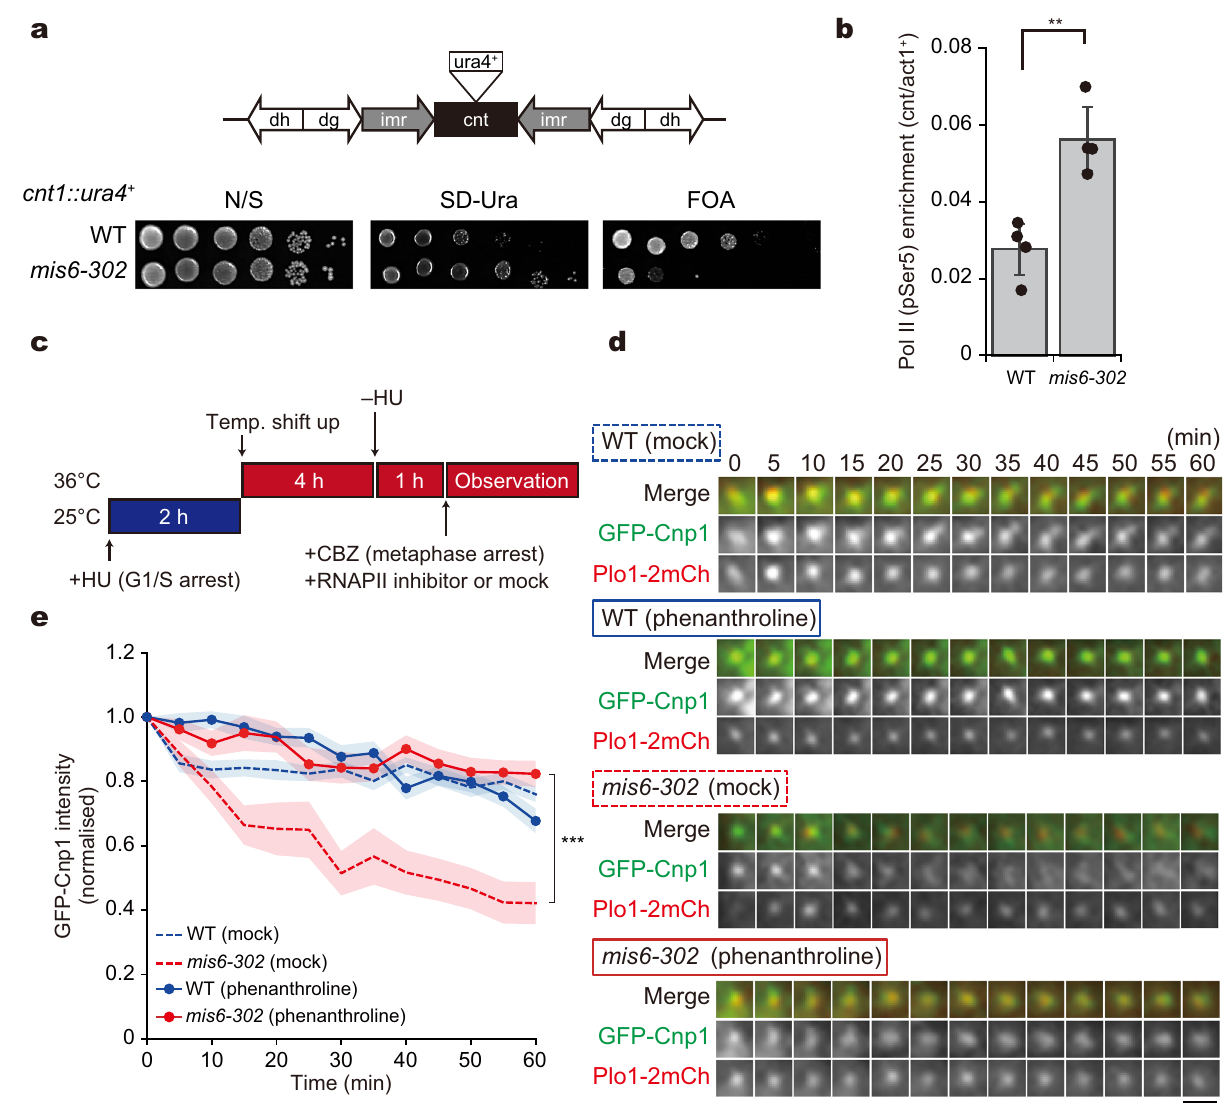
Fig. 4 Loss of Cnp1 in mis6-302 cells is coupled with centromeric transcription by RNA polymerase II. a A schematic illustrating the centromeric DNA structure and ten-fold serial dilution assay. For silencing assays, the ura4 + gene is inserted in the central core ( cnt ) region ( cnt::ura4 + ) in chromosome I. imr , the innermost repeats; dg and dh , the outer repeats. Ten-fold serial dilution of WT and mis6-302 cells with cnt::ura4 + , grown on nonselective (N/S), uracil-de fi cient (SD – Ura) and counter-selective (5- fl uoroorotic acid, FOA) media at 25 °C. b Chromatin IP (ChIP) for phosphorylated RNA polymerase II (RNAPII pSer5) at cnt region (the central core region) in WT and mis6-302 cells at 36 °C (4 h). The % input of the cnt region was normalised to that of the act1 + region. Error bars = ±s. d. ( N = 4 experiments). ** p < 0.01 (Welch ’ s t -test). c – e RNAPII was inhibited in WT and mis6-302 cells expressing GFP-Cnp1 and Plo1-2mCherry. c Experimental design. Cells arrested to G1/S at 25 °C were shifted up to 36 °C to inactivate Mis6 or Alp12. The cells were then released into mitosis and arrested at metaphase using the microtubule poison carbendazim (CBZ). Cells were treated with an RNAPII inhibitor (1,10- phenanthroline) or mock treatment prior to observation. d Time-lapse imaging of GFP-Cnp1 (green) with Plo1-2mCh (red) in WT and mis6-302 cells with or without the inhibitor. Scale bar = 2 µ m. e A Cnp1 maintenance assay. Temporal kinetics of the GFP-Cnp1 fl uorescence intensity during metaphase in the indicated samples were monitored. WT (mock, blue dashed line), n = 22 cells; mis6-302 (mock, red dashed line), n = 17 cells; WT (phenanthroline, blue solid line), n = 30 cells; mis6-302 (phenanthroline, red solid line), n = 20 cells. The data are normalised to the intensities at 0 min, and the mean is shown as solid and dashed lines. The coloured regions indicate the standard error (s.e.m.). *** p < 0.001 (Welch ’ s t